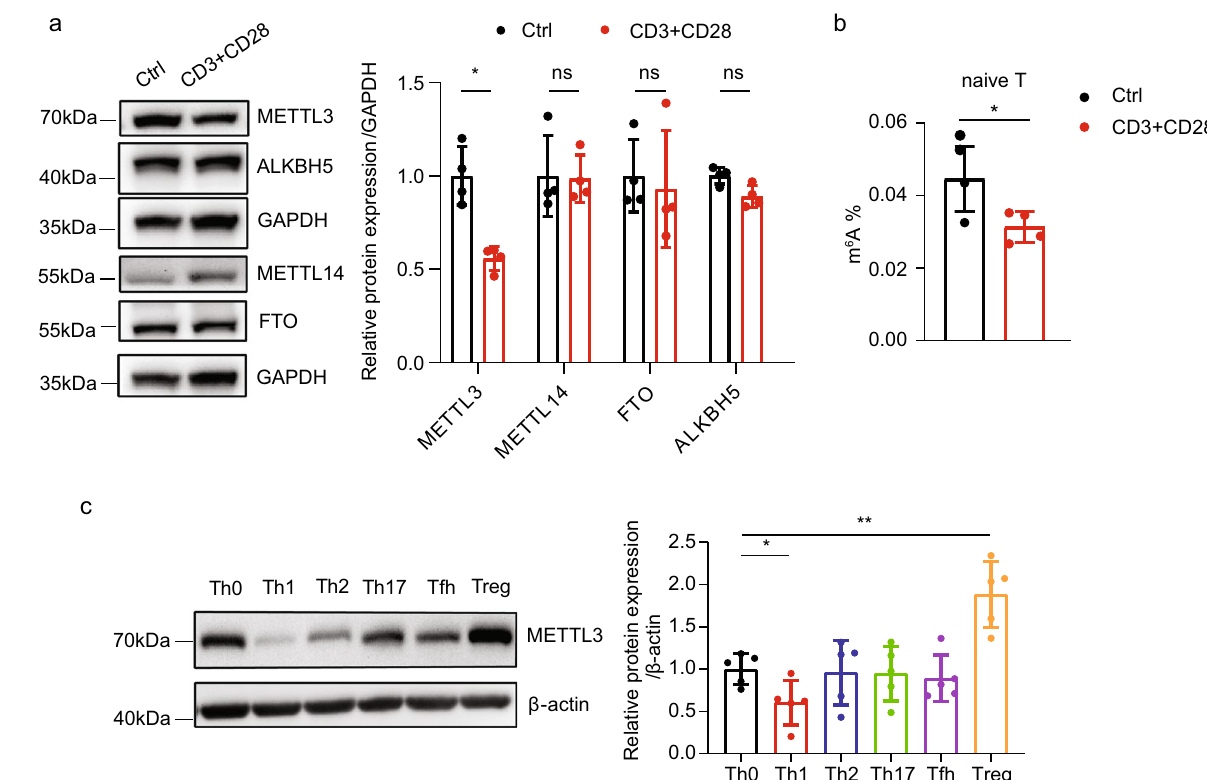
Fig. 2 METTL3 expression varies after inducing T-cell activation and differentiation in vitro. a Left: the protein levels of the m 6 A-modifying enzymes METTL3, METTL14, ALKBH5, and FTO in naïve CD4 + T cells activated by anti-CD3 and anti-CD28 antibodies relative to control cells were determined by Western blot analysis. GAPDH was used as a loading control; right: quantification of protein levels, n 4. b Total m 6 A modification level in naïve = CD4 + T cells before and after activation was examined by m 6 A colorimetric quantification, n 4. c Left: Western blot analysis of METTL3 protein = expression among polarized Th1, Th2, Th17, Tfh, and Treg cell subsets relative to Th0, and β-actin was used as a loading control; right: quantification of METTL3 protein expression among different T-cell subsets, n 5. (* p < 0.05, ** p < 0.01, ns, no significance, two-way ANOVA with Sidak’s multiple = comparisons test for a , unpaired two-tailed Student’s t test for b , one-way ANOVA with Dunnett’s multiple comparisons test for c )